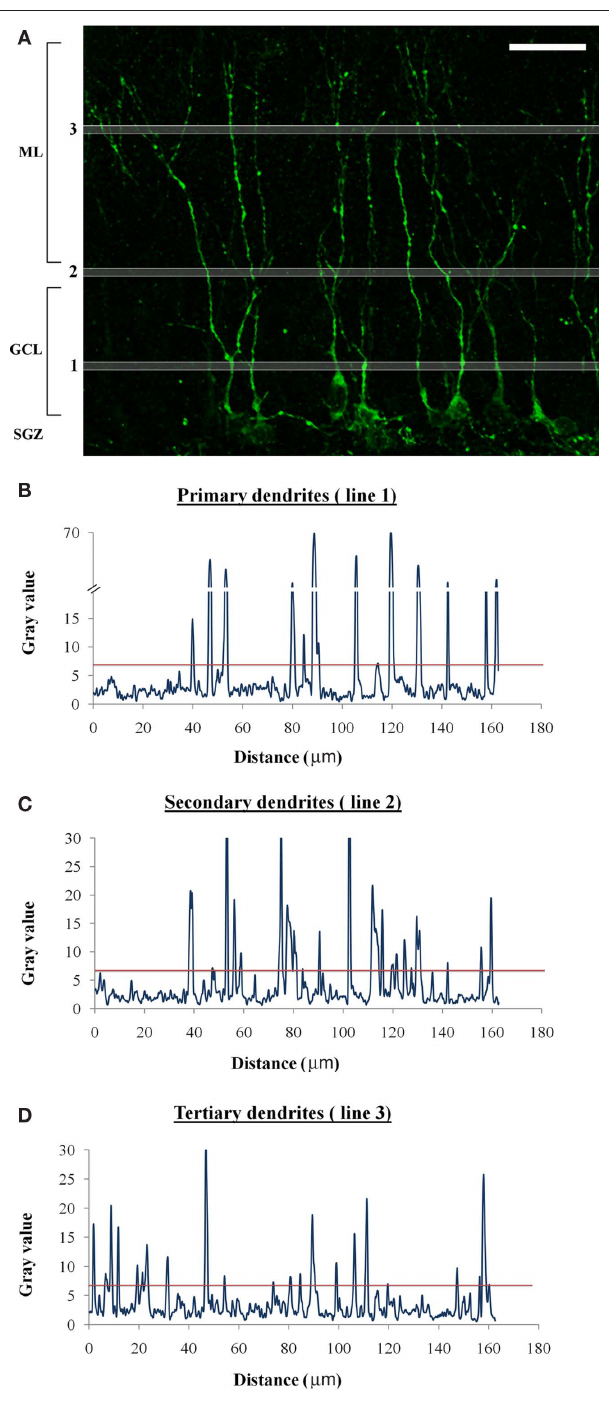
Figure 2 | example of dendritic quantification. (A) High-resolution confocal stack image of a section through the DG immunostained for DCX. DCX-positive cell bodies are arranged along or just above the SGZ, primary dendrites are quantified along line 1 in the middle of the GCL, secondary dendrites are quantified along line 2 on the outer edge of the GCL and tertiary dendrites are quantified along line 3 in the ML. Scale bar = 20 μm. (B–D) plot profiles for lines 1–3 obtained using ImageJ software. The red line indicates the threshold (set for 7) and all the peaks that cross it are